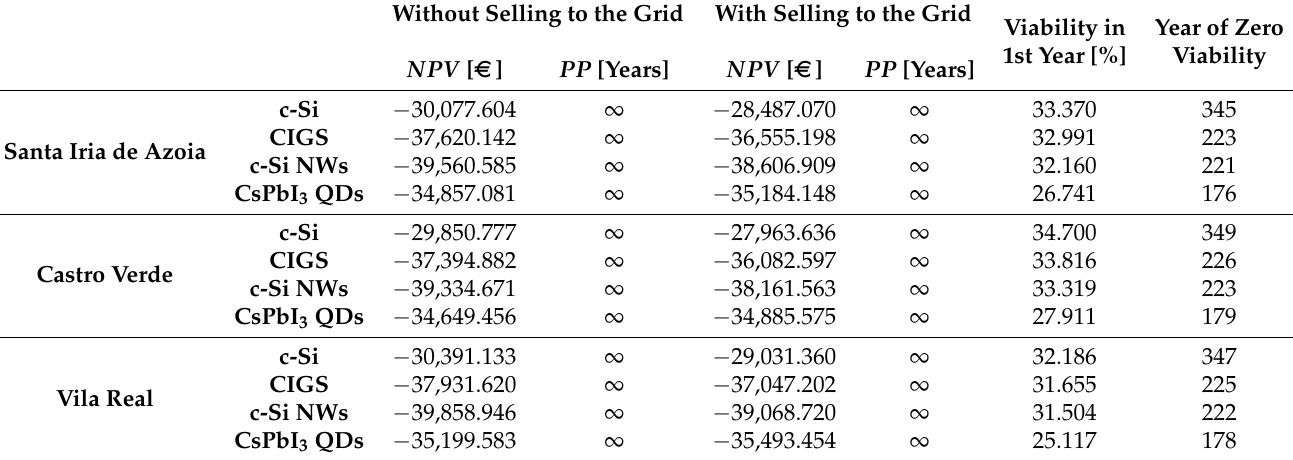
Table 5. Financial indicators in the three locations under analysis, with partial shading